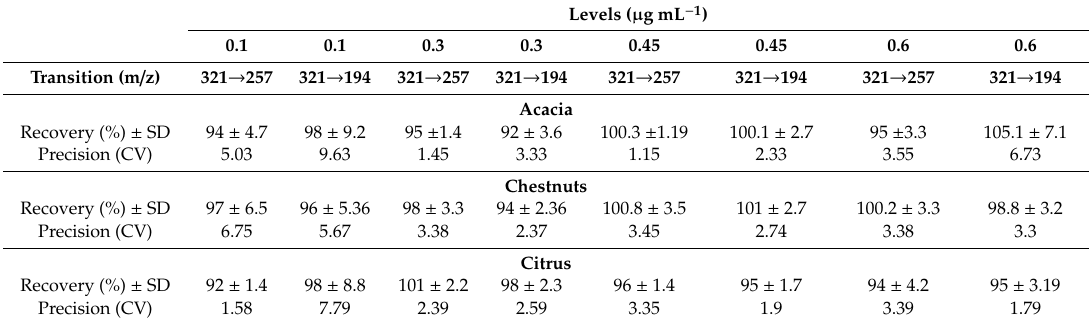
Table 3. Performances of the analytical